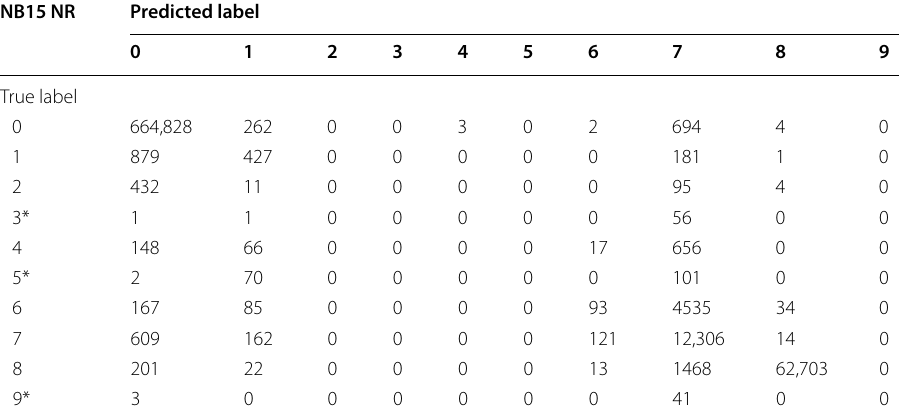
Table 22 Confusion Matrix: NB15 NR NB15 NR